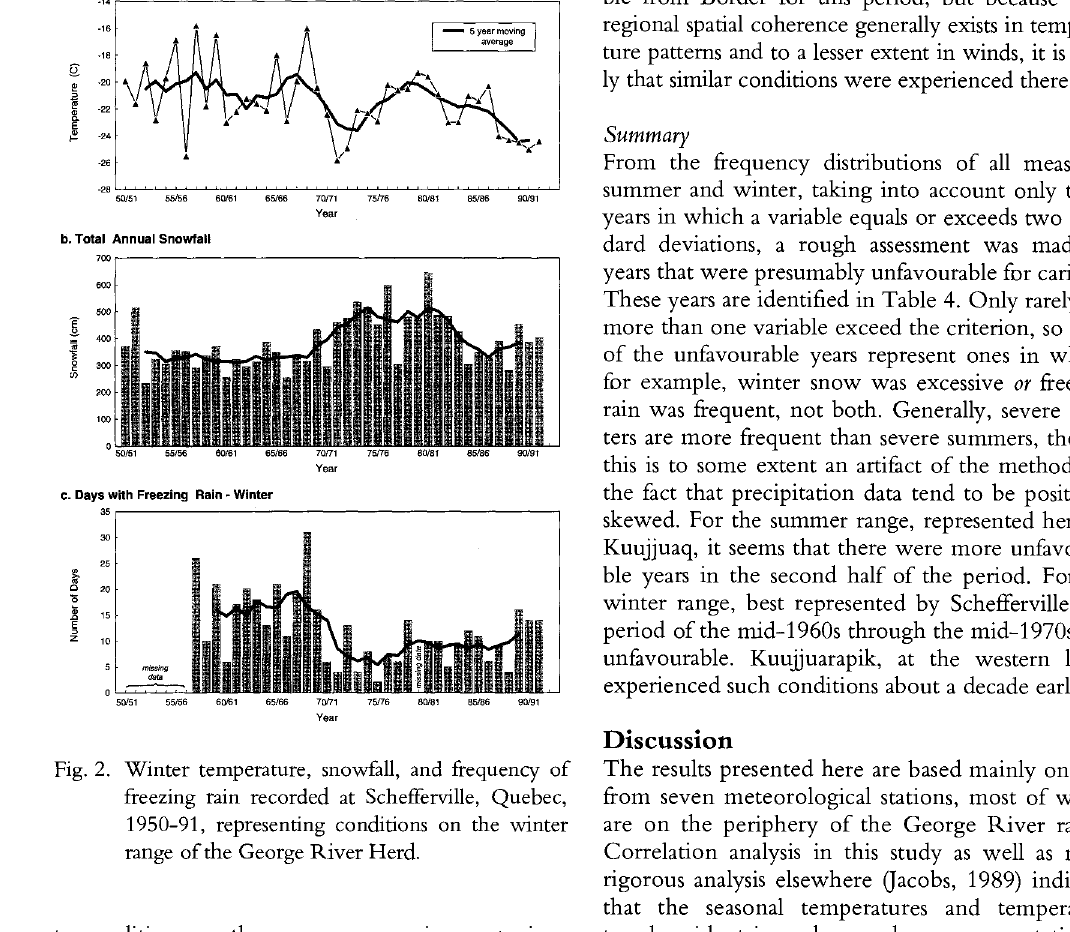
te conditions on the summer range in comparison with Border and Schefferville.